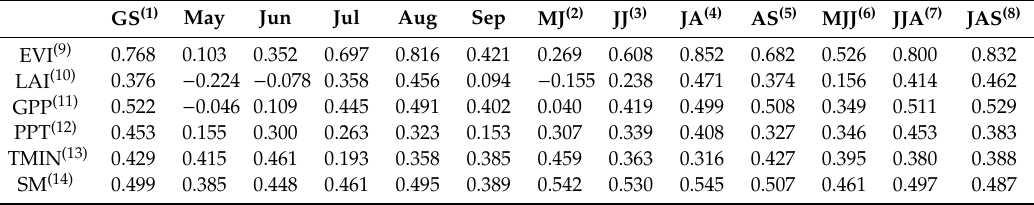
Table 5. Correlation coe ffi cients between the selected variables and soybean yields according to combinations of months,